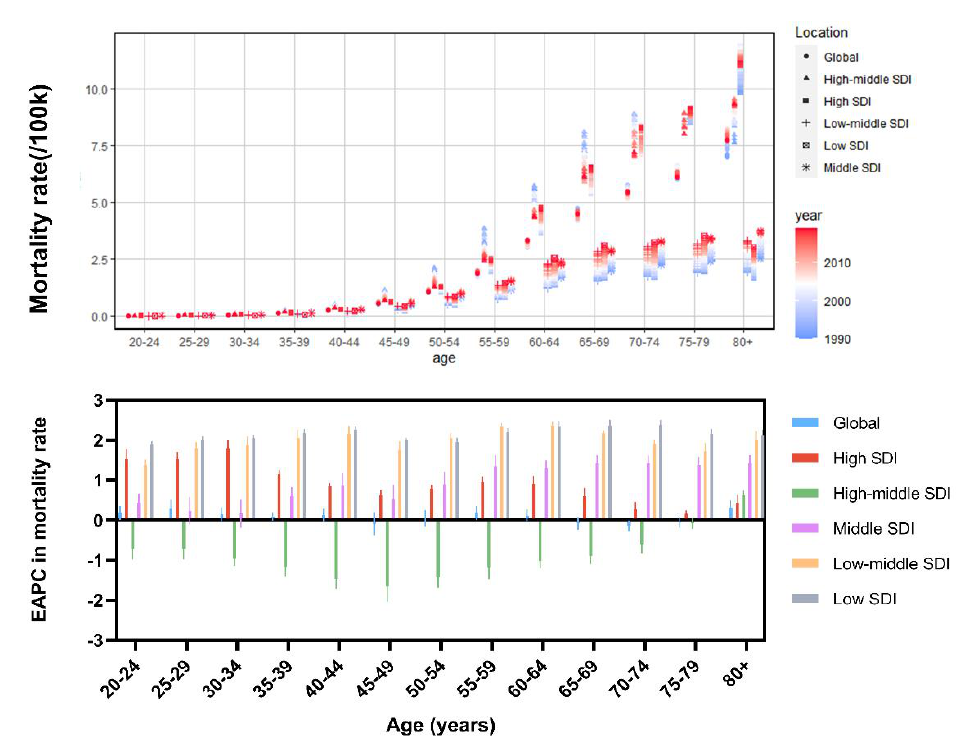
Figure 3. Mortality rate among different age groups in the global and SDI regions in 2019 and their EAPC between 1990 and 2019. SDI, Socio-demographic Index; EAPC, Estimated annual percentage change.